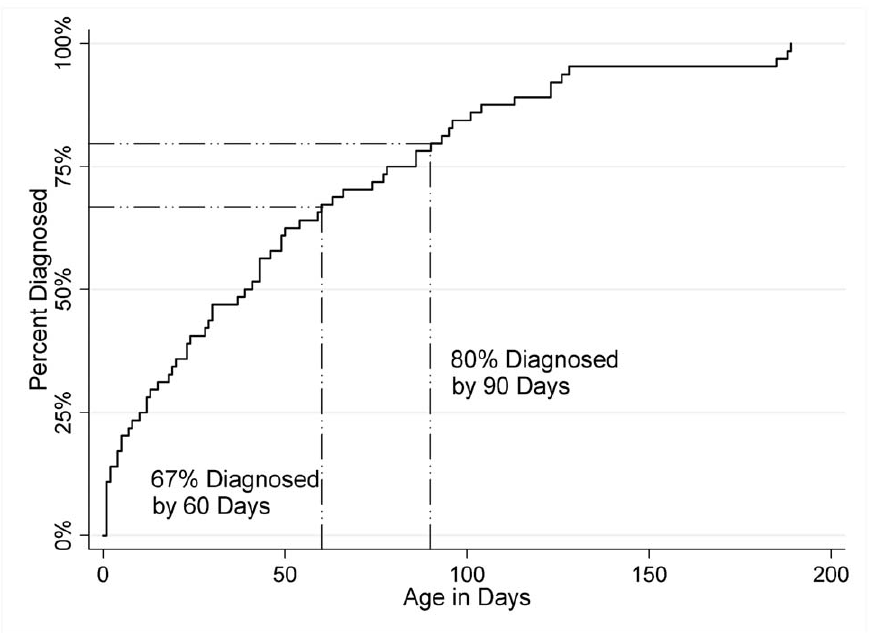
Figure 2. Cumulative prevalence of documented biliary atresia within the Military Health System by age at diagnosis.